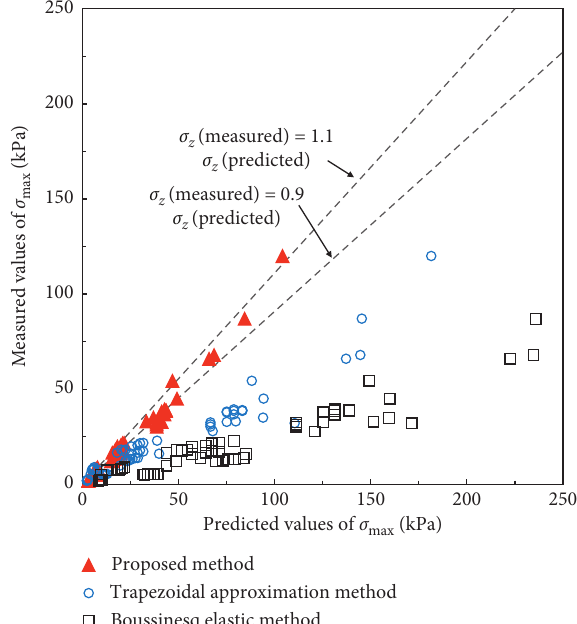
Figure 7: Comparisons between predicted results in the proposed method and measured vertical train loading. Indraratna et al. [22] introduced the void contaminant index (VCI) for railway ballast to quantify the extent of fouling. VCI = 0% represent fresh ballast.